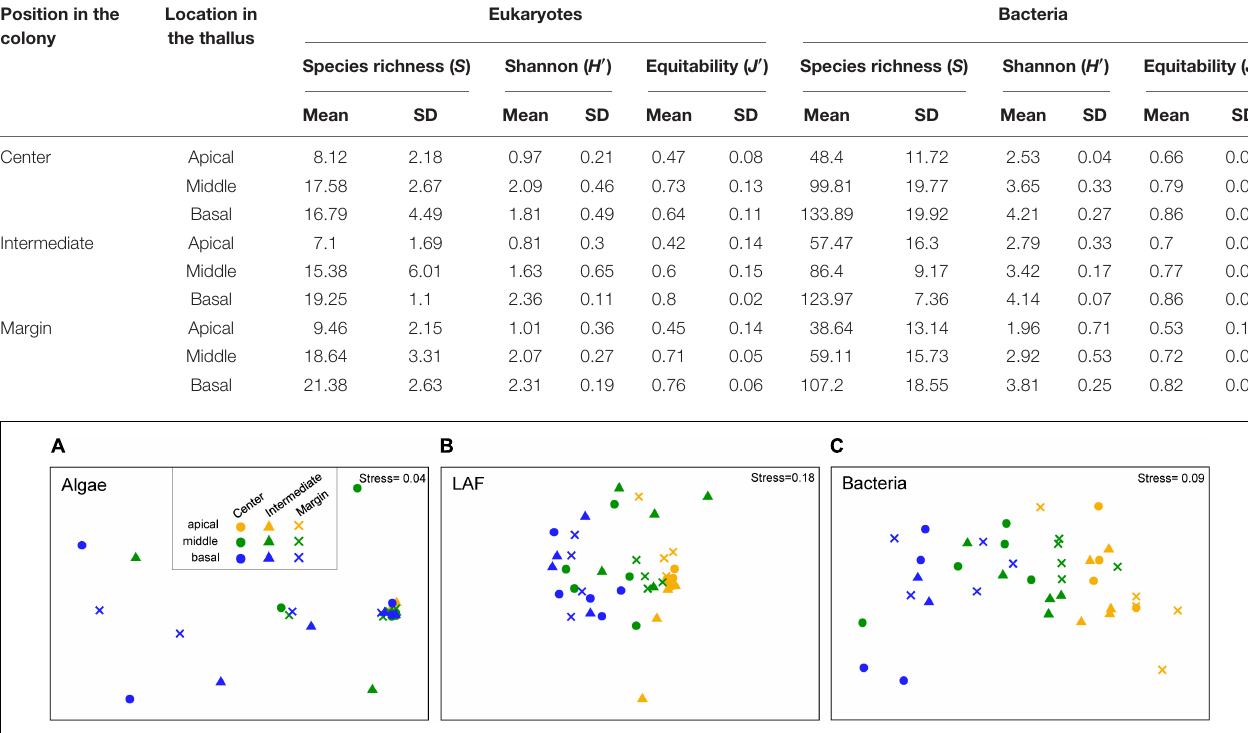
TABLE 1 | Diversity indices of eukaryotic and bacterial communities according to the position. Position in the colony